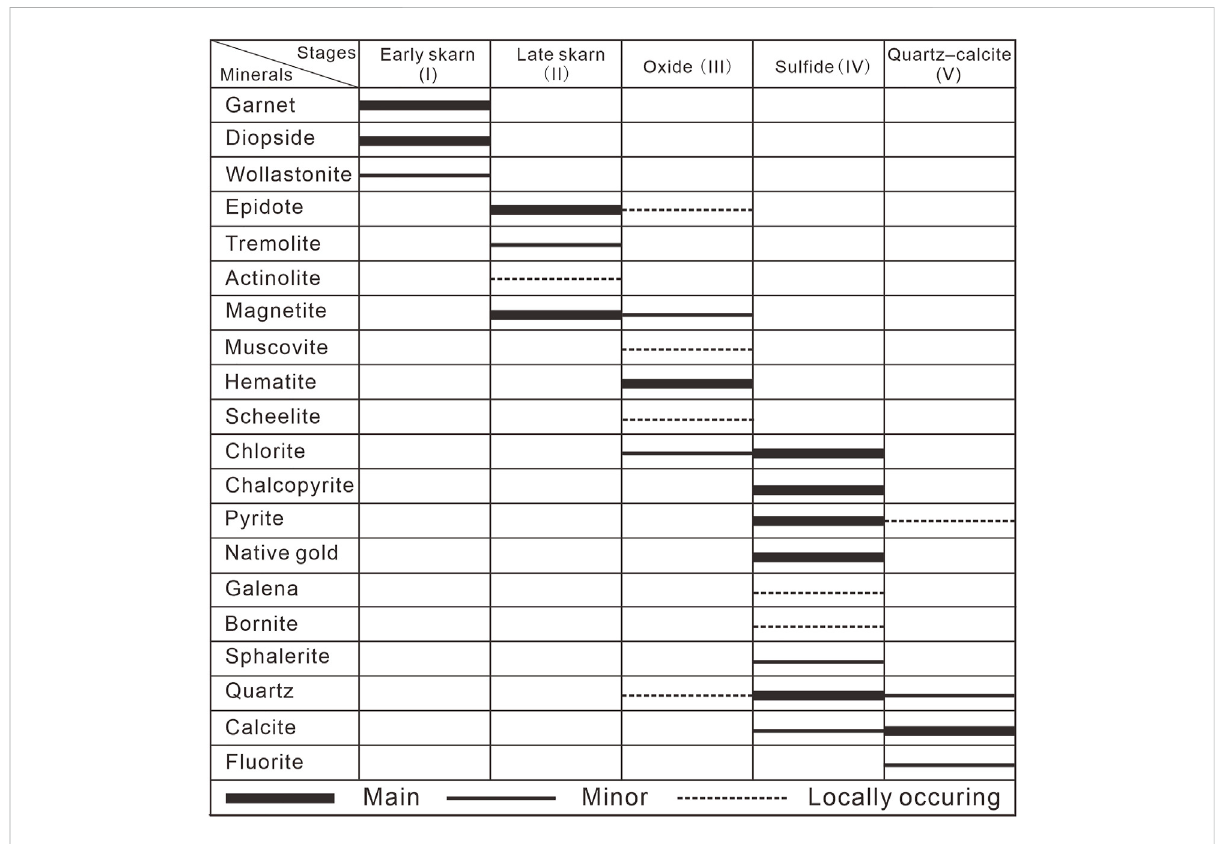
FIGURE 7 Mineral paragenesis for the Yi ’ nan Tongjing Au – Cu